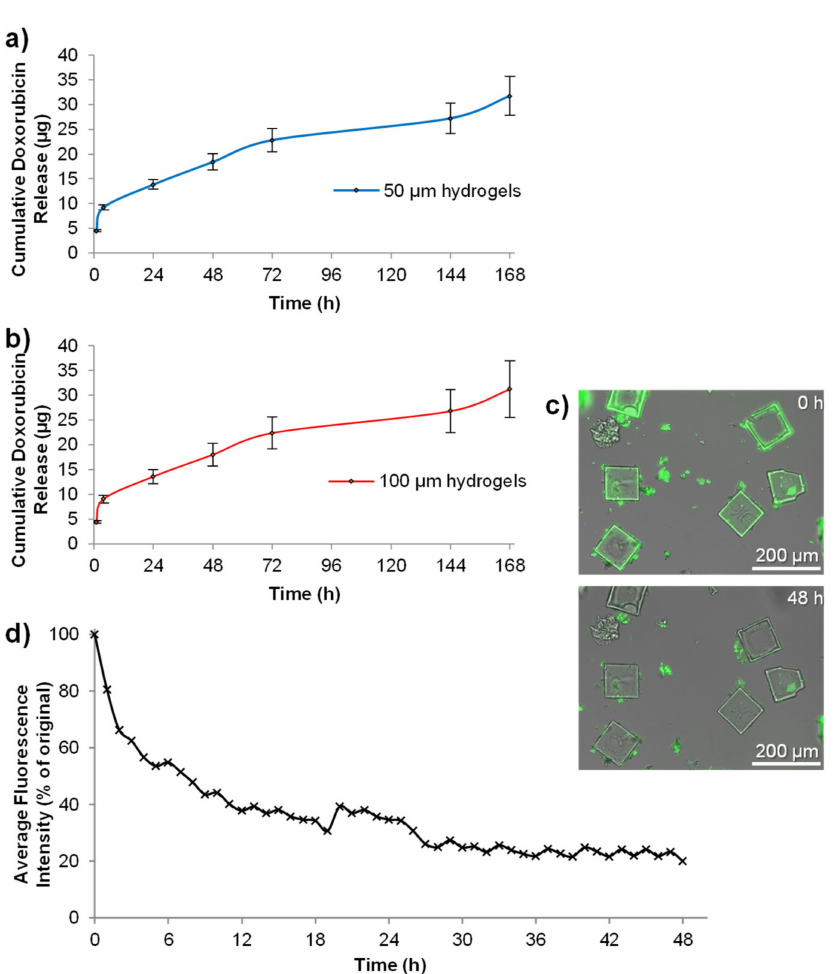
Figure 4. Doxorubicin is released from the microscale hydrogels steadily over 7 days. We show that 50 µ m width hydrogels ( a ) and 100 µ m width hydrogels ( b ) released doxorubicin into PBS over a period of 7 days ( n = 4, error bars represent ± standard deviation). Microscale hydrogels could also be visualized by time-lapse fluorescence microscopy due to the intrinsic fluorescence of doxorubicin ( c ), showing a drop in fluorescence intensity over 48 h ( d